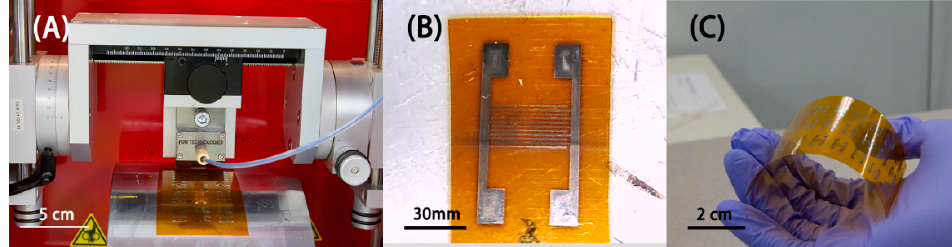
Figure 6. ( A ) slot-die coating setup, showing the coating head during the deposition process on top of IDEs pre-printed on Kapton; ( B ) a single IDE with the active area (digits) coated by the SnO 2 -rGO composite; ( C ) final array of ca. 30 flexible sensors for CO.